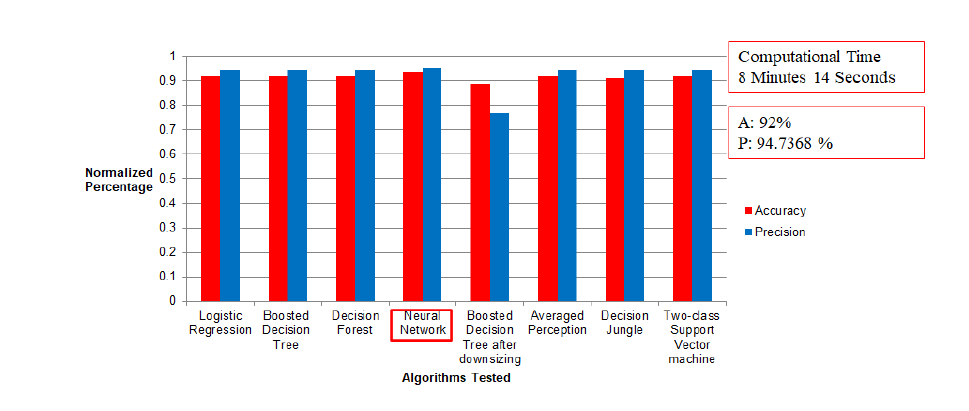
Figure 9. Binary classification model results for half case.